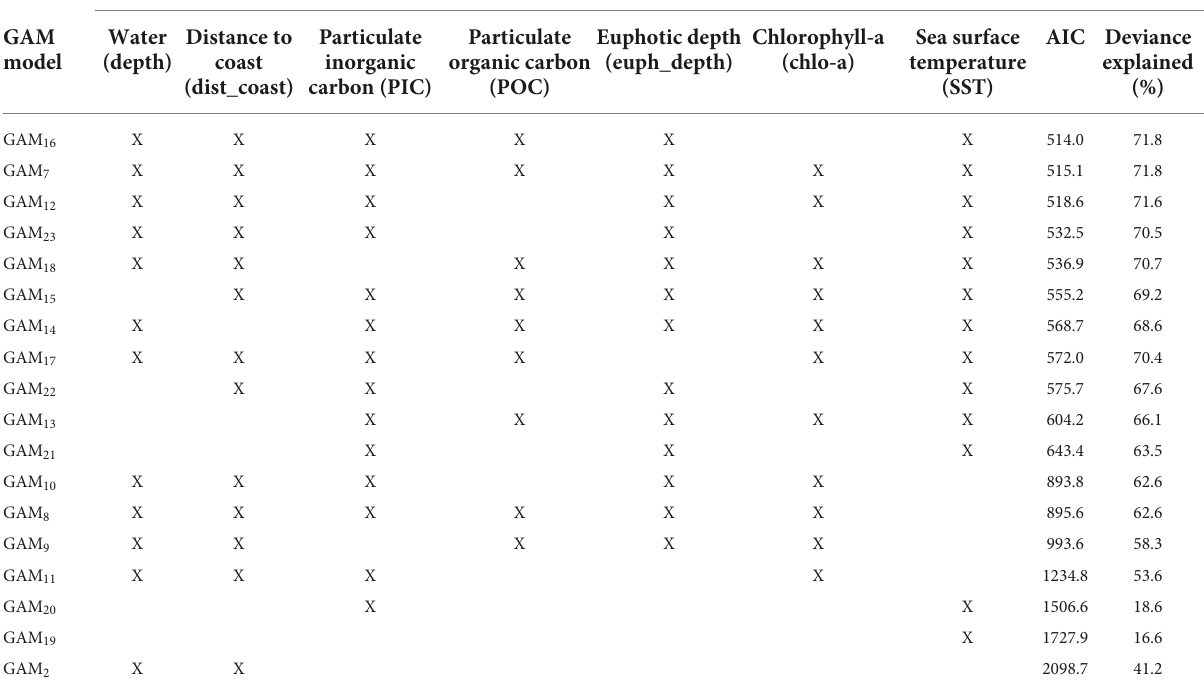
TABLE 2 General additive model selection for habitat preference model of olive ridley turtles in the Eastern Tropical Pacific using different environmental variables as predictors for